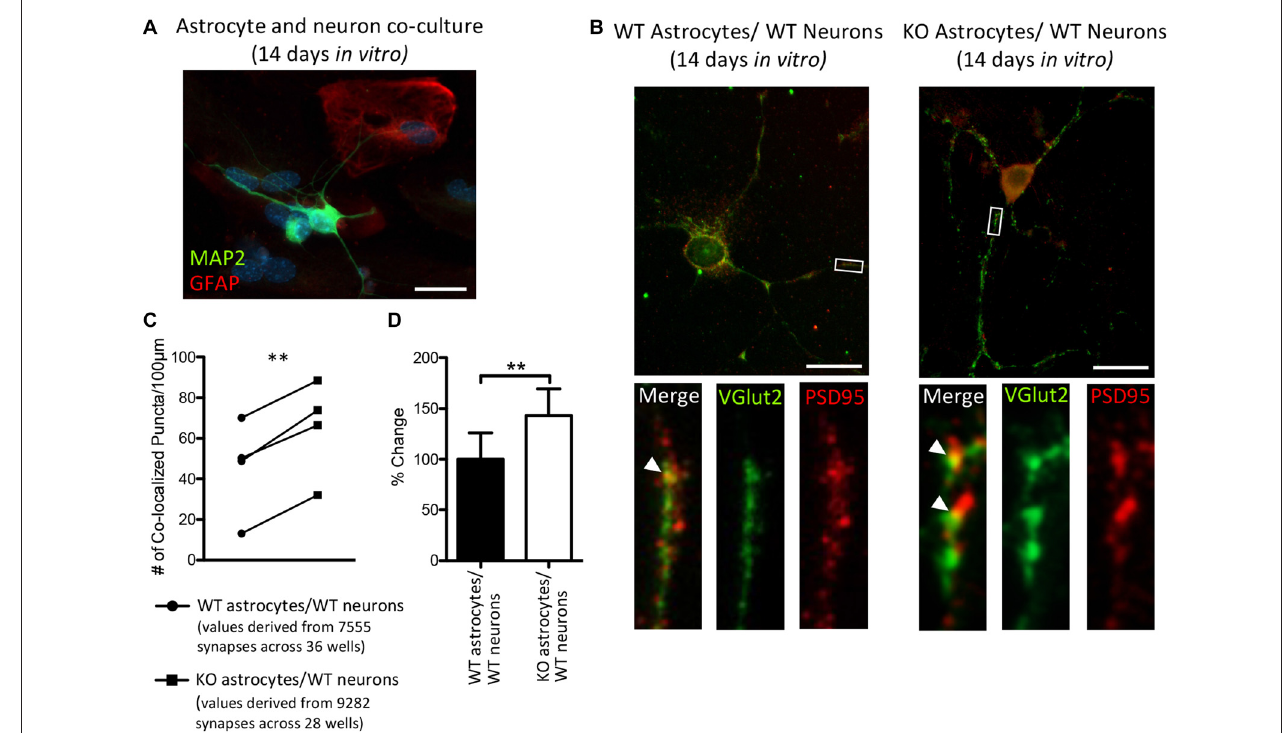
FIGURE 6 | After 14 days in vitro the density of VGlut2 + / PSD95 + co-localized puncta is increased in co-cultures of Fmr1 KO astrocytes and WT neurons, relative to co-cultures of WT astrocytes and WT neurons. WT cortical and thalamic neurons were isolated from P1 pups via magnetic-activated cell sorting (MACS) separation and co-cultured with either WT or Fmr1 KO astrocytes isolated from P1 or 2 pups. Co-cultures were maintained for 14 days in vitro . (A) A co-culture with WT neurons and Fmr1 KO astrocytes co-labeled with anti-GFAP (red) and anti-microtubule associated protein 2 (MAP2; green) to visualize astrocytes and neurons, respectively. (B) Co-cultures co-labeled with antibodies against vesicular glutamate transporter-2 (VGlut2) and post-synaptic density protein 95 (PSD95) to visualize pre-synaptic and post-synaptic puncta, respectively. White arrows indicate co-localized Vglut2 + (green) and PSD95 + (red) puncta. (C) Measures of thalamocortical synapse number (identified by the co-localized VGlut2 + and PSD95 + puncta) were obtained from cultures containing WT astrocytes ( n = 4) and cultures containing Fmr1 KO astrocytes ( n = 4) and normalized to dendrite length. (D) The density of thalamocortical synapses in co-cultures containing Fmr1 KO astrocytes (white) was expressed as a percentage of the density of thalamocortical synapses in co-cultures containing WT astrocytes (black). Images were obtained using a 40 × objective with a Zeiss Axioimager M2. Scale bars = 25 µ m. Statistical differences were denoted with a double asterisks, P < 0.005.